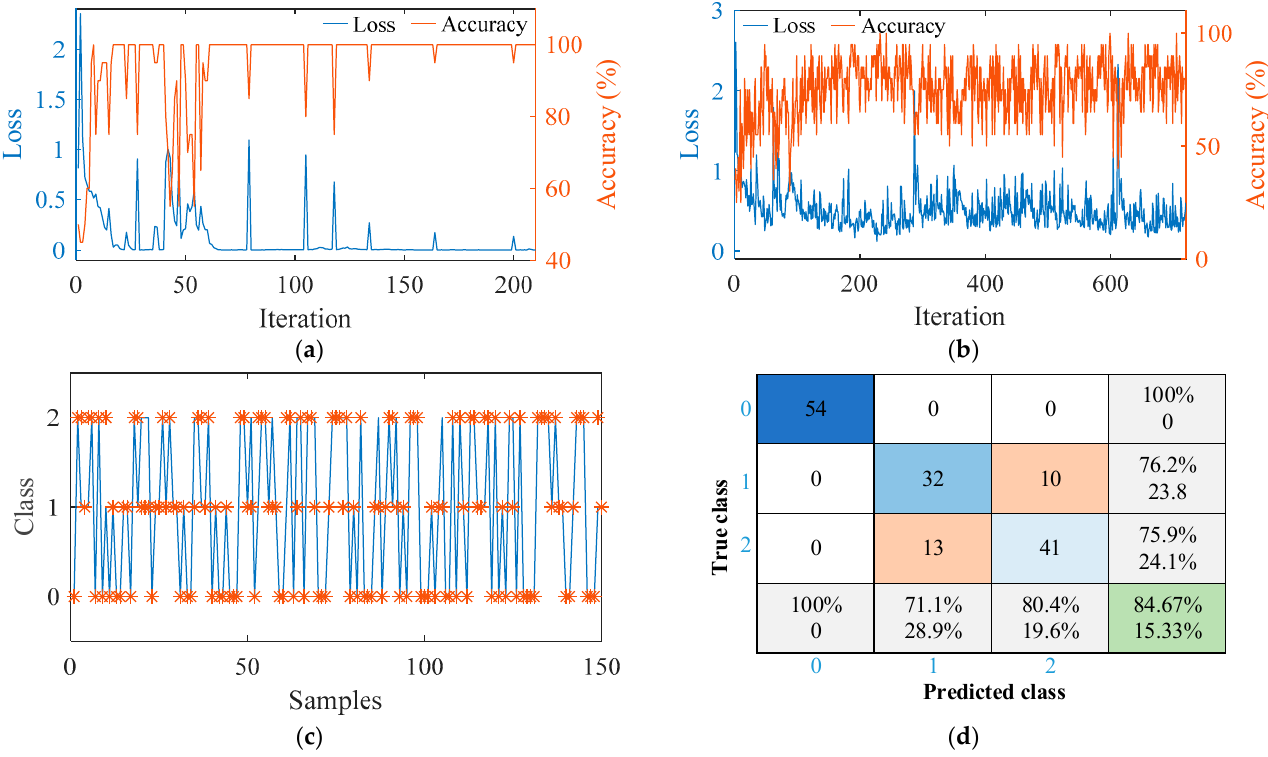
Figure 16. Welding quality classification based on LSTM: ( a ) training process of the binary classifi- cation model; ( b ) three-classification model; ( c ) testing results of the three-classification model; ( d ) confusion matrix of testing results in ( c ).